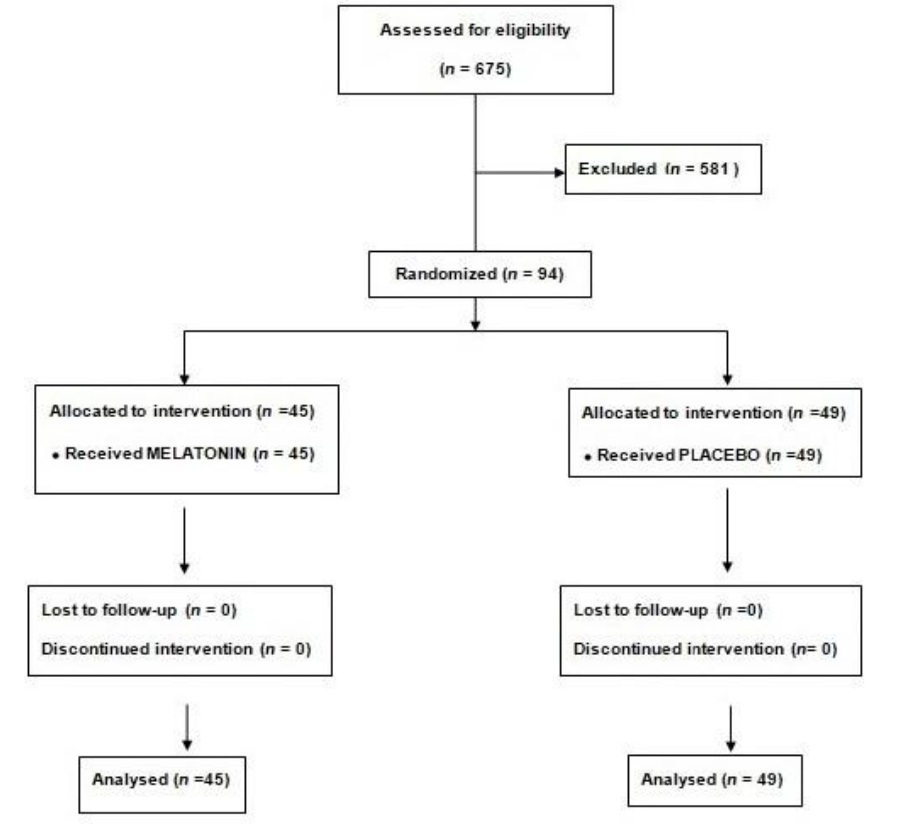
Figure 1. Consort diagram.